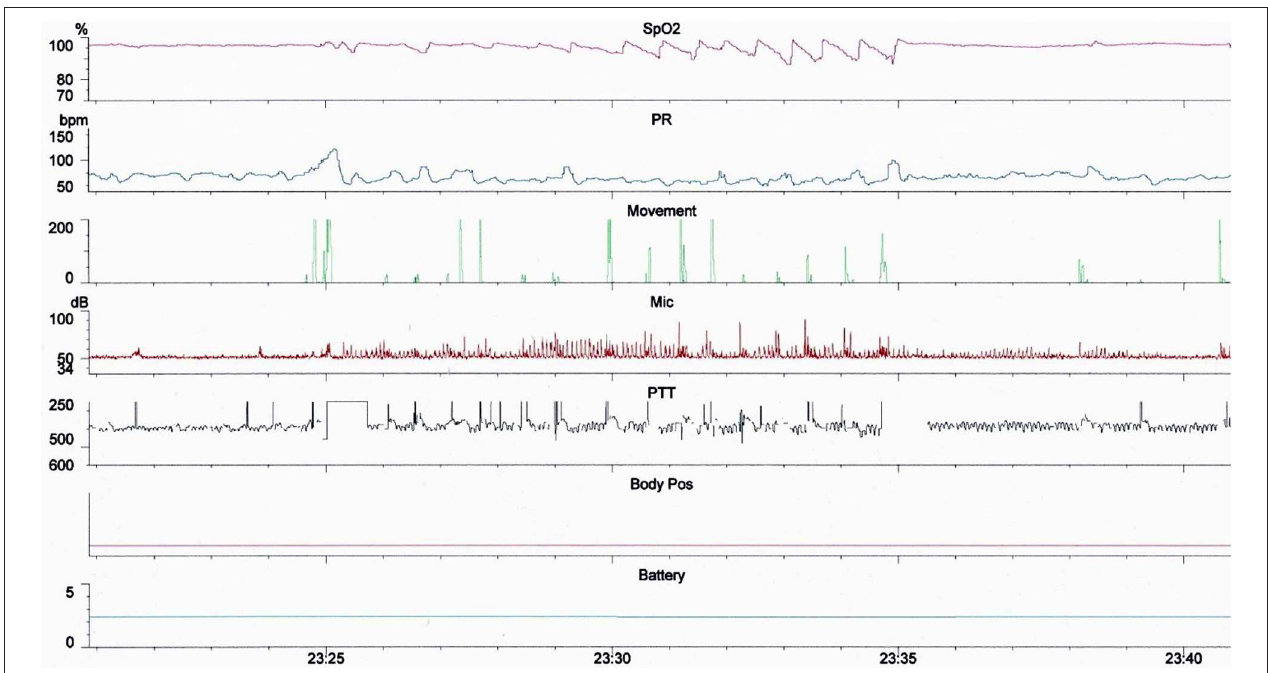
FIGURE 1 | Example of a 20min epoch of the multi-channel study montage.